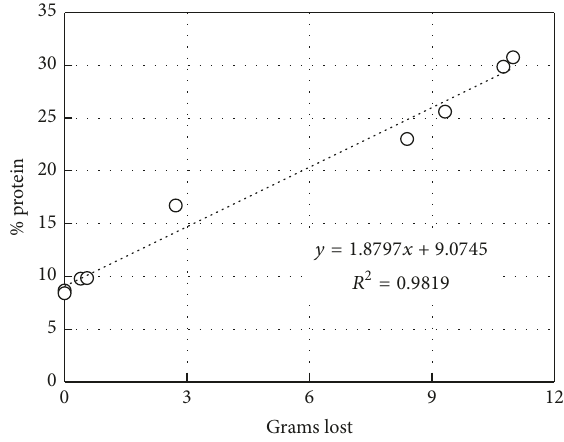
Figure 2: A correlation between substrate mass loss, at expenses of carbon dioxide escaping the flasks, and percent protein increase due to biomass production observed in baker’s yeast fermentation. Original substrate was approximately 160 grams (40g sorghum and 120 g sterile deionized water).